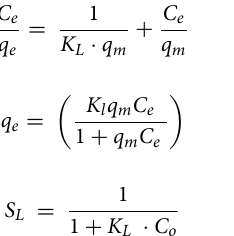
PA-ATC Fit Curve of MF-WTC Fit Curve of MF-ATC Fit Curve of PA-WTC Fit Curve of PA-ATC